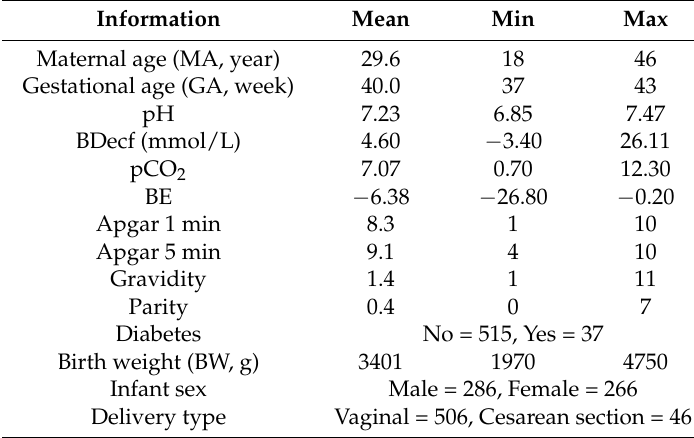
Table 1. An overview of the information available in the open access CTU‐UHB cardiotocography (CTG) database.